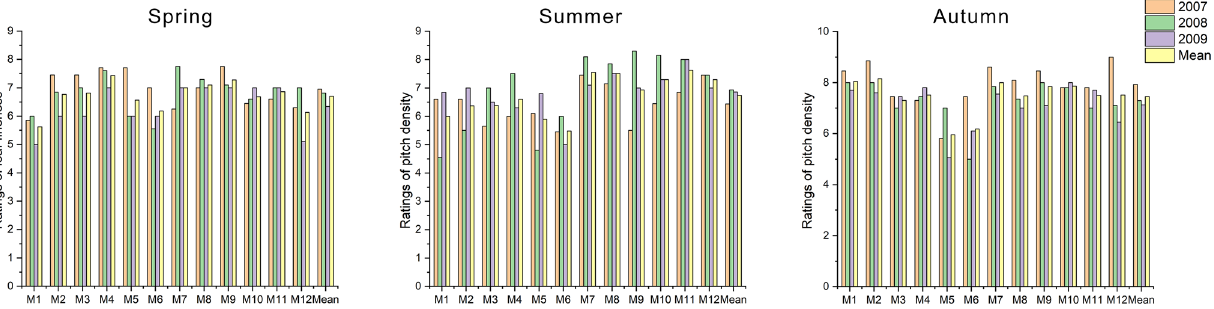
Figure 4. Ratings of leaf fineness across grass mixtures and research green’ (1.99). The colour of the same turf, defined on average as ‘greyish green’ (4.41), was the least favourable across all summers. The colour of as many as eight pitches was assessed as ‘grassy green’. However, bluegrass M8 (7.67) was rated the highest. The values of seven remaining mixtures (M2, M3, M6, M7, M10, M11, M12) were in the range of 7.02–7.34.